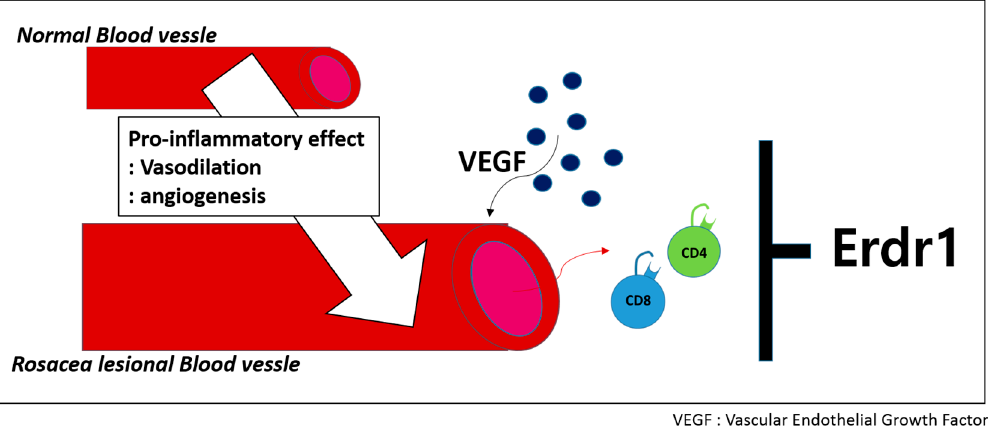
Figure 3. Erdr1 is suggested as a candidate target for rosacea treatment due to its anti-inflammatory and anti-angiogenic effects.